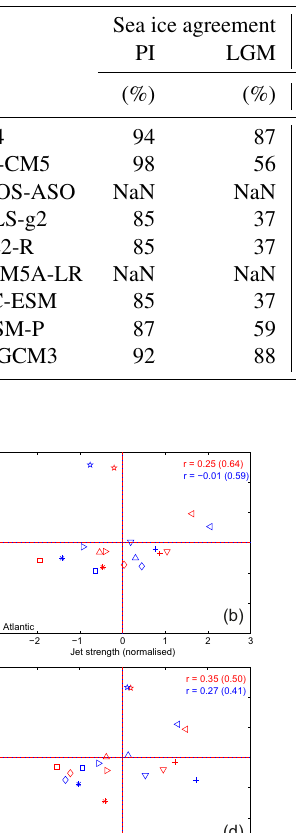
Table 3. The model–data agreement from the sea ice edge latitude, the mean zonal sea ice edge latitude, and the PI to LGM jet shift. Simulation results are bi-linearly interpolated to each Gersonde et al. (2005) observation site. Model–data agreement is then calculated by classing simulated sea ice as present or absent, analogous to the exact metric defined by Sime et al. (2013). A simple agreement percentage metric is then calculated using the equivalent Gersonde et al. (2005) sea ice (present or absent) observations.